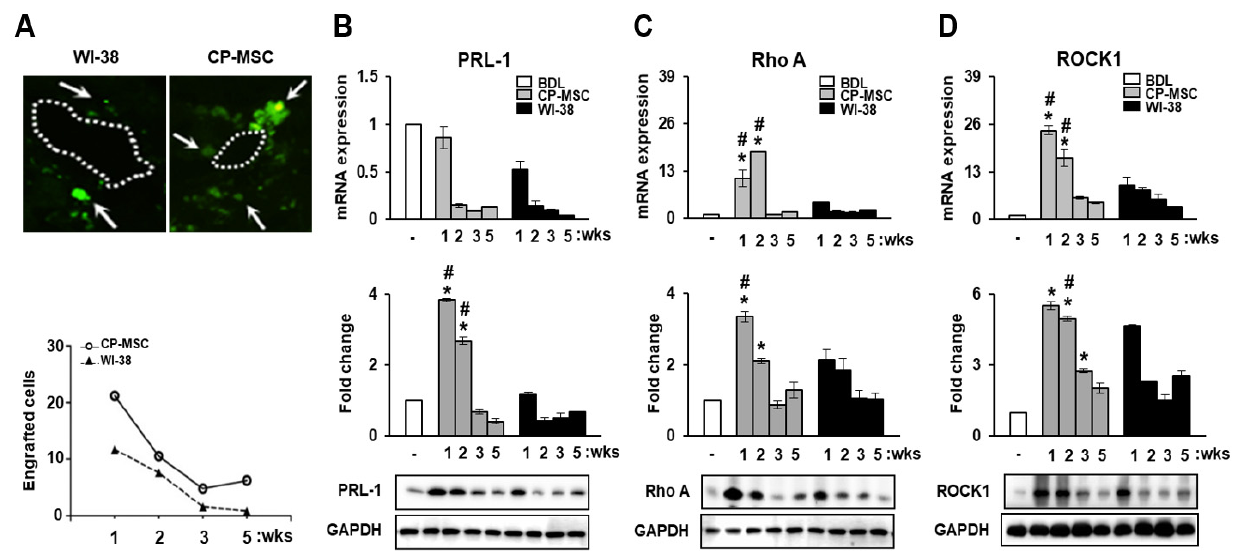
Figure 3. PRL-1-mediated signal induces the homing of CP-MSCs into the BDL-injured rat liver via Rho family proteins. ( A ) PKH67-labeled CP-MSCs and WI-38 cells engrafted into BDL-injured rat liver tissue by immunofluorescence at 5weeks (upper) and FACS (lower). The arrow indicates the engrafted cells near a liver vein. The scale bar represents 50 µ m. Expression levels of ( B ) PRL-1, ( C ) Rho A, and ( D ) ROCK1 were determined by quantitative RT-PCR (upper) and Western blotting (lower) in BDL (1 weeks), CP-MSCs, and WI-38-transplanted livers (1, 2, 3, and 5 weeks). Total RNA and protein from liver in each group were pooled (at least five rats per group). GAPDH was used as an internal control. Each experiment was repeated three times. The data are expressed as the mean ± SEM (* p < 0.05 compared with the BDL group; # p < 0.05 compared with the WI ‐ 38transplantation group).